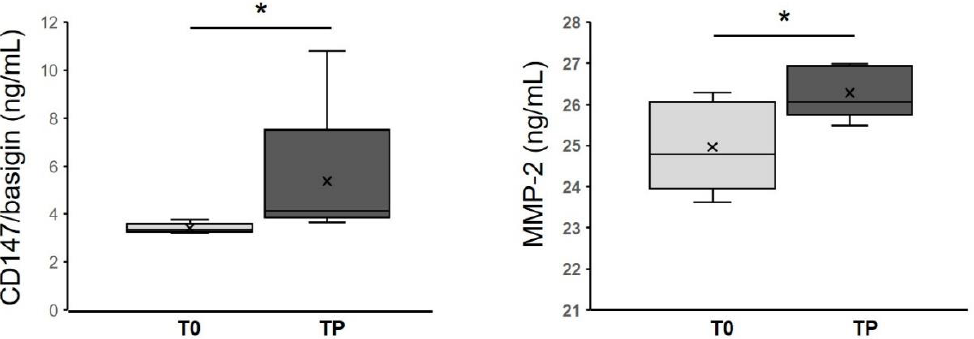
Figure 7. Plasma concentrations of CD147/basigin and MMP-2 in patients with BRAF V600 -mutant metastatic cutaneous melanoma treated with either vemurafenib or vemurafenib plus cobimetinib. The median plasma levels of the indicated molecules in blood samples collected before the start of therapy (T0) were significantly lower than those collected at disease progression (TP). Statistical significance: * p < 0.05.